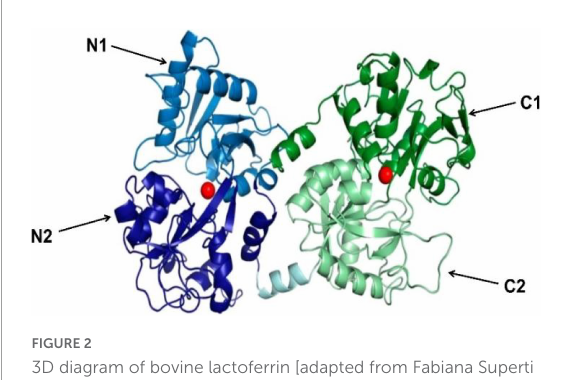
FIGURE2 3D diagram of bovine lactoferrin [adapted from Fabiana Superti et al. (103)]. N-lobe is blue (N1 is light blue, N2 is dark blue), C-lobe is green (C1 is dark green, C2 is light green). The peptide bonds linking N-lobe and C-lobe are expressed in light cyan. The Iron ion is a red